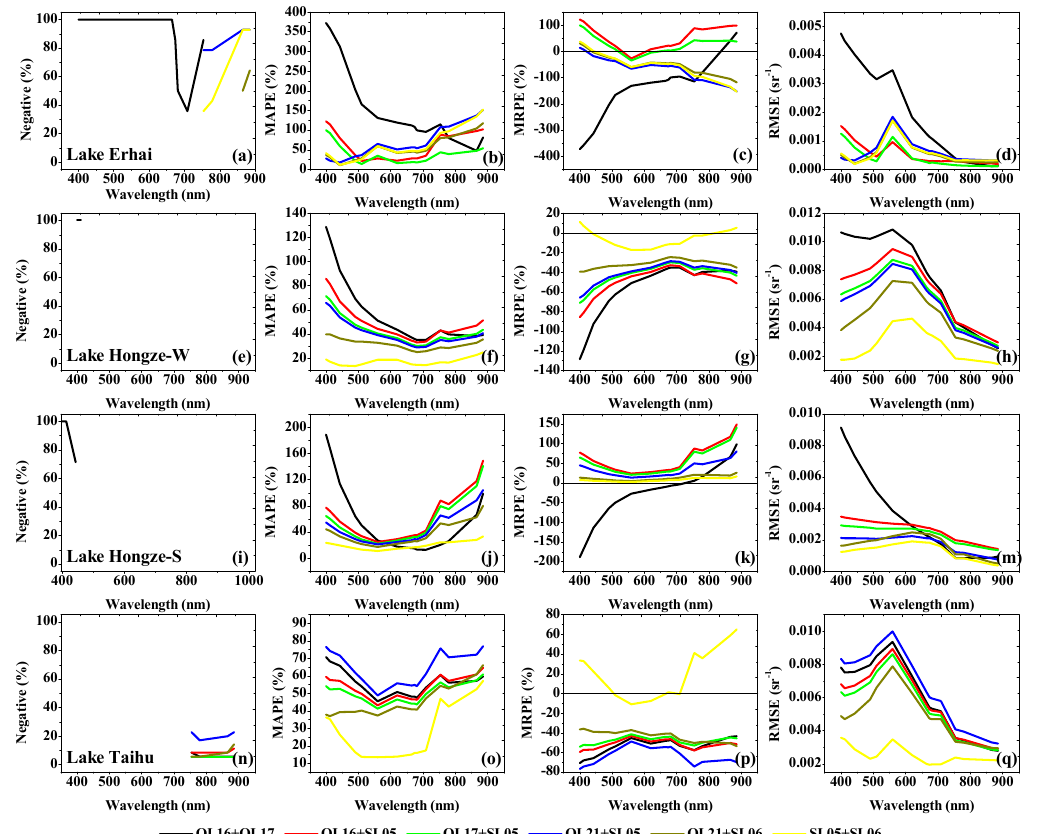
Figure 16. Comparisons of six pairs of selected atmospheric correction bands regarding %Negative ( a , e , I , n ), MAPE ( b , f , j , o ), MRPE ( c , g , k , p ), and RMSE ( d , h , m , q ) in Lake Erhai, Lake HongzeW, Lake HongzeS, and Lake Taihu ( n = 72). Table 3. The full-band average values of the MAPE, MRPE, and RMSE of the atmospheric